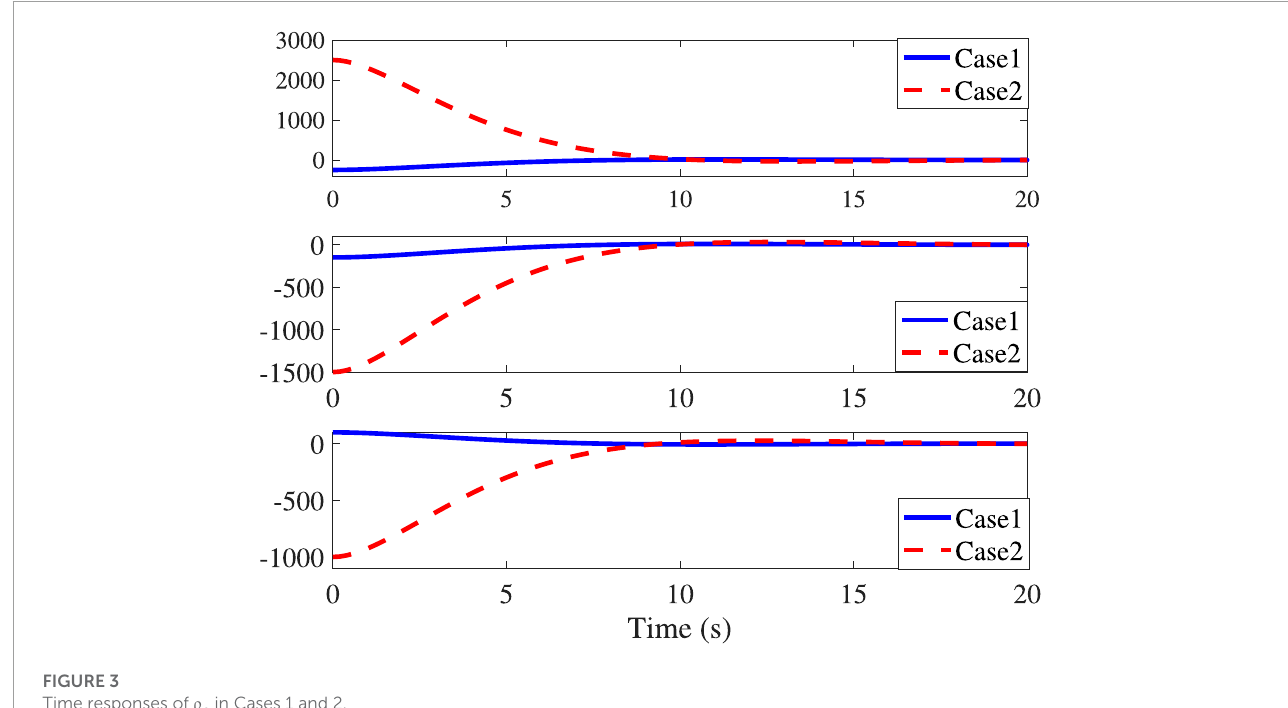
FIGURE 3 Time responses of ρ e in Cases 1 and